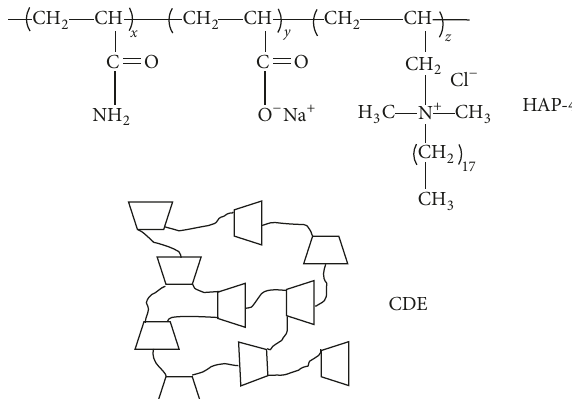
Figure 1: Schematic structure of HAP-4 and CDE. CDE displays a hyperbranched